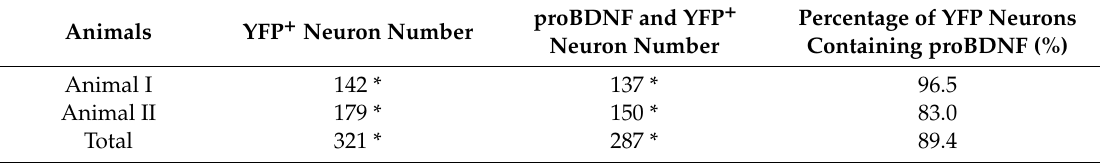
Figure 3. Expression of proBDNF in hippocampal glutamatergic and GABAergic neurons. ( A – C ) Table 2. Colocalization of the precursor proBDNF protein in YFP + INs in immunolabeled hippocampal sections.